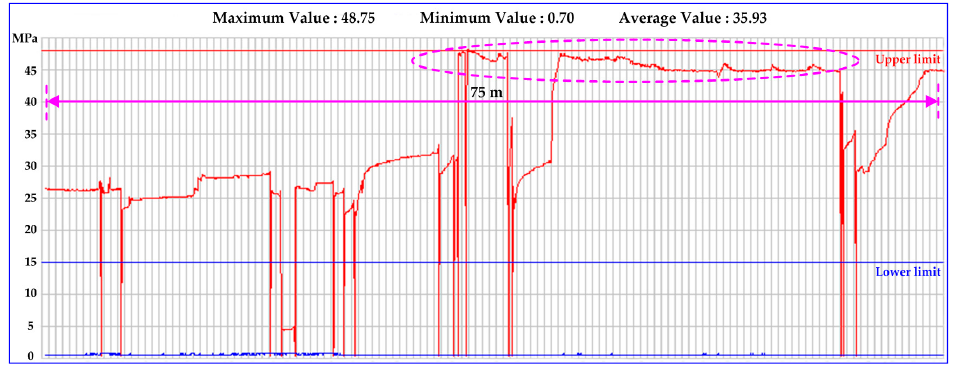
Figure 17. Working resistances on the HSs when the coalface moved 75 m forward.